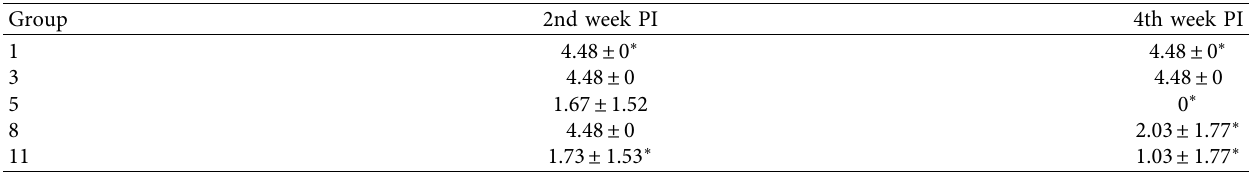
Table 5: Statistical analysis of total Salmonella Enteritidis count in groups challenged with MDR (log of mean ± SD). Group